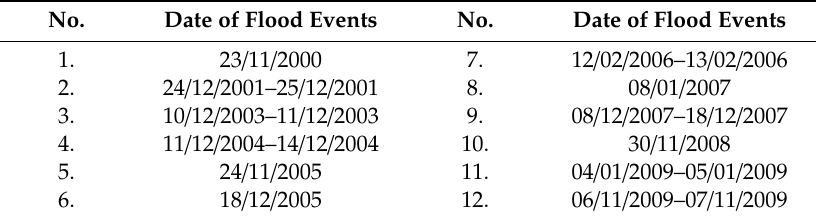
Table 2. List of dates of the water level data that exceeded the danger water level (16 m) of Kelantan River at the Guillemard Bridge station from 1 January 2000 until 13 October 2010.